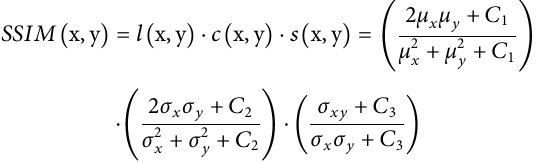
Frontiers in Earth Science |